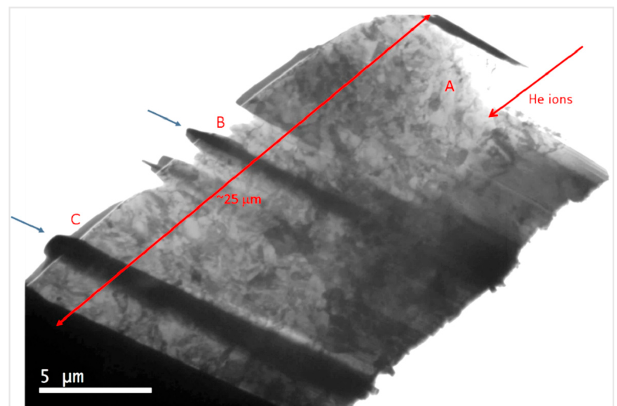
Figure 8. TEM micrograph overview of the lamella obtained from the EU-ODS EUROFER steel annealed at 450 °C for 100 h evenly thinned. The red arrow indicates the implantation surface. A, B, and C indicate areas with different He content and blue arrows show separators.